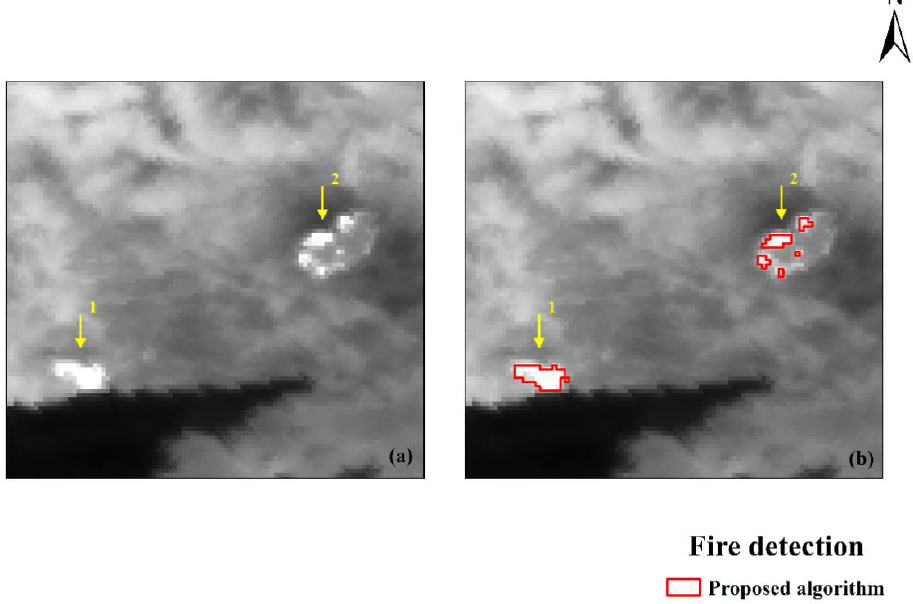
Figure 4. Fire detection results in Bodrum, Turkey, on 5 August 2021. ( a ) MIR channel image; ( b ) Detection results of the proposed algorithm.